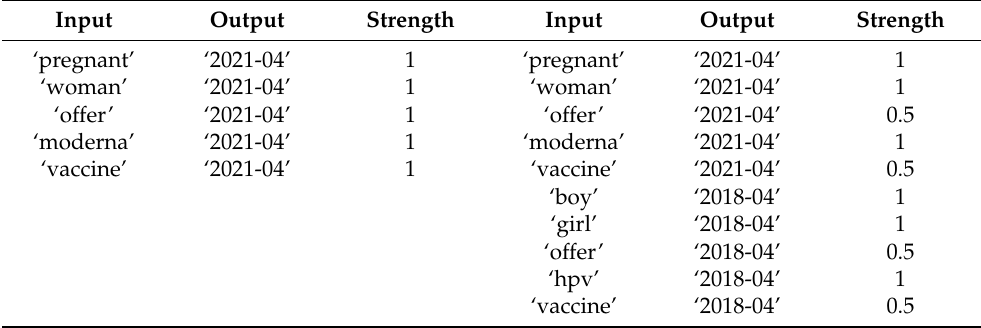
Table 1. Initially uniform associations on the left and updated associations on the